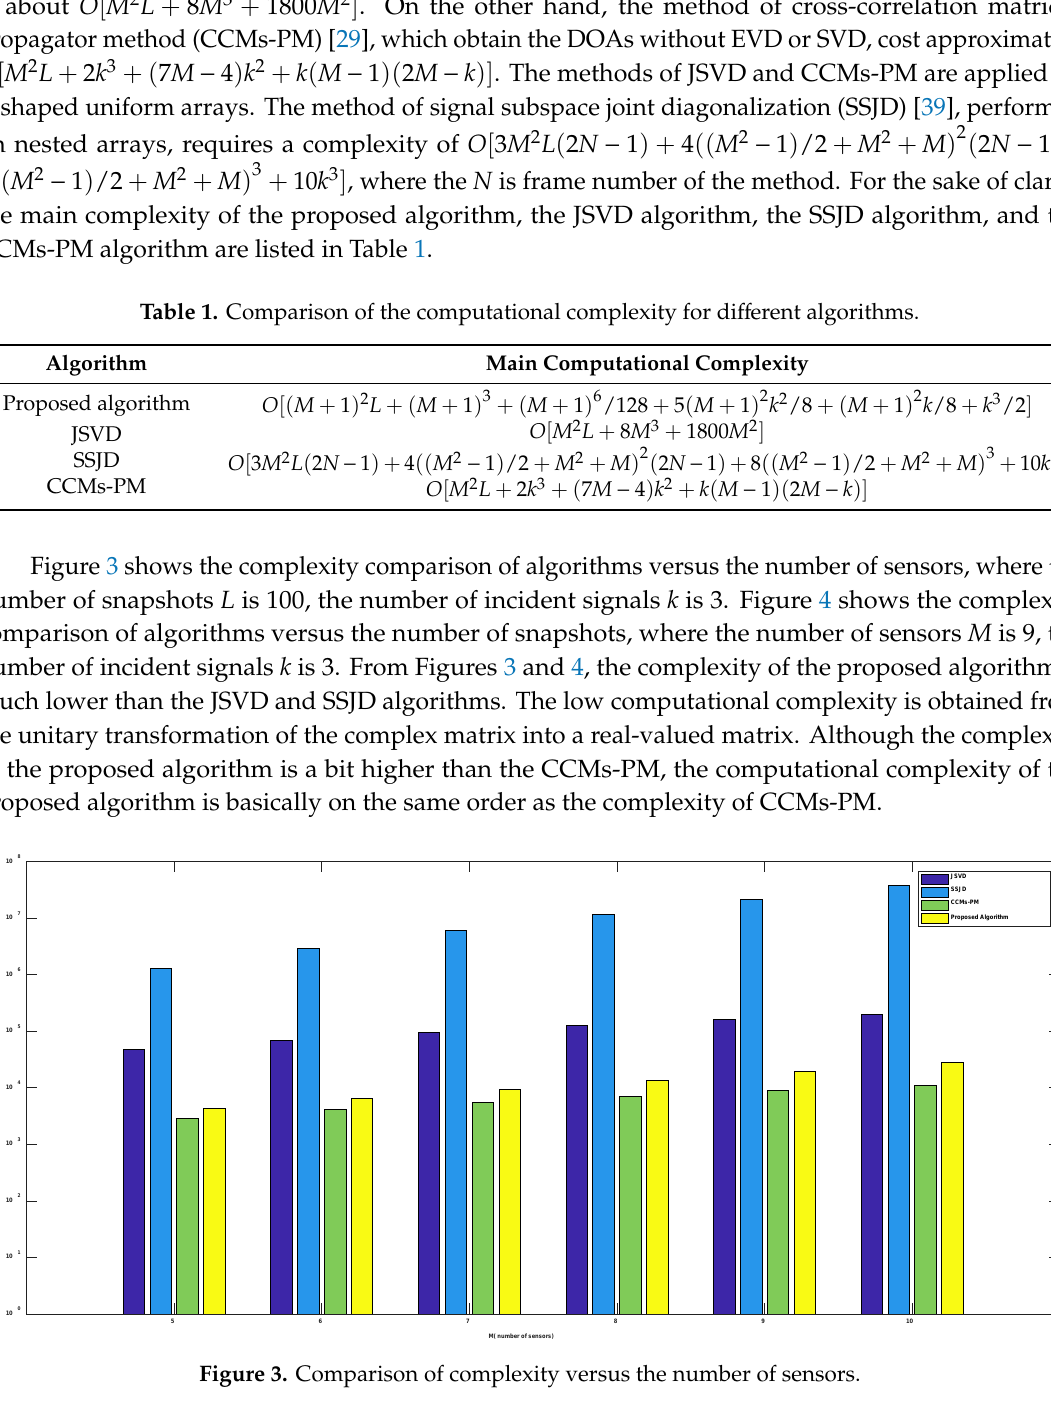
Figure 4. Comparison of complexity versus the number of snapshots.